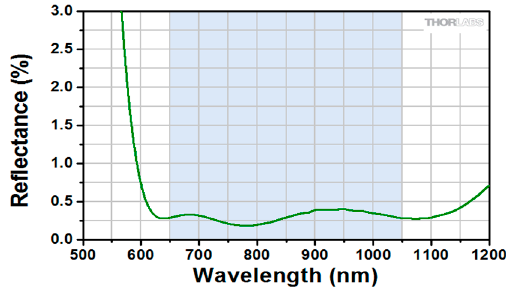
Figure 4. Transmittance of laser beam expander.